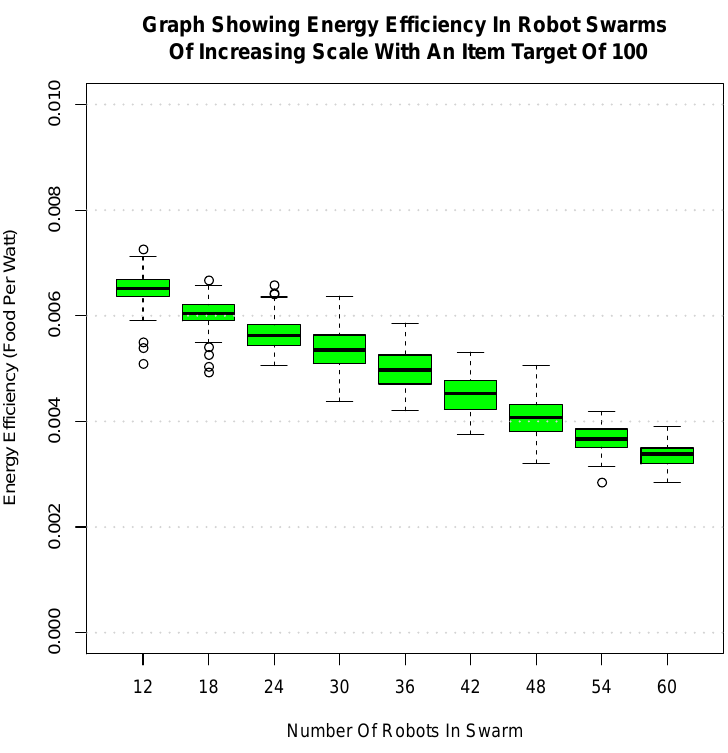
Figure 17. Results for energy efficiency as the number of robots in the swarm increases from 12 to